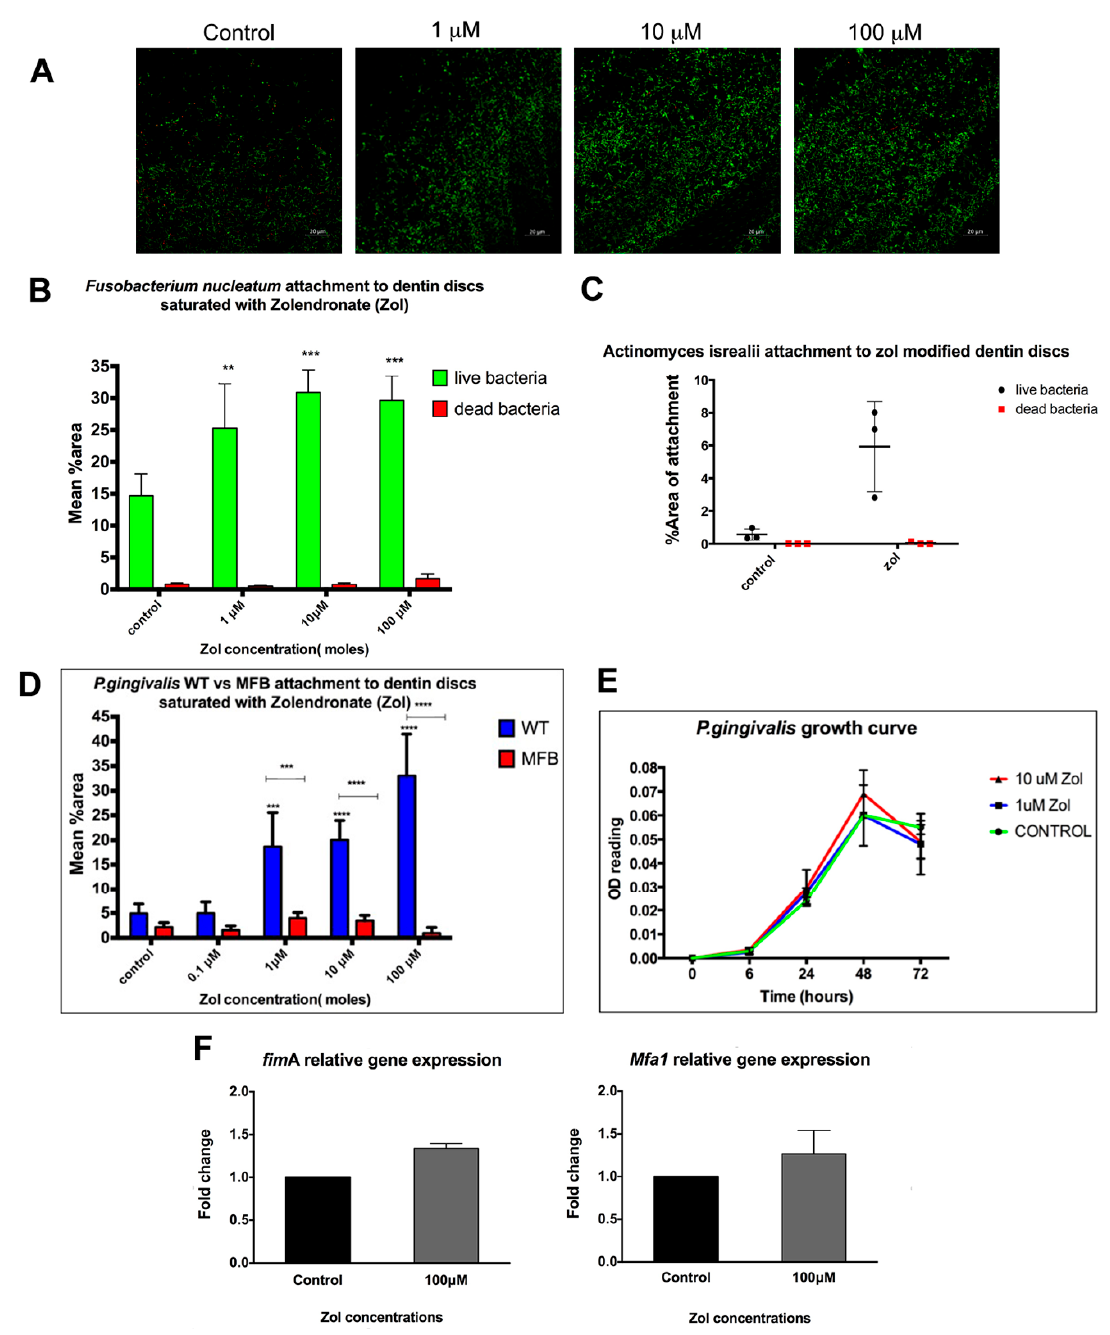
Figure 1. Effect of matrix-bound zol on the attachment of different bacterial strains. ( A ) Confocal microscopy images of F. nucleatum stained with a fluorescent live (green) and dead (red) stain on zol-coated dentin discs. ( B ) Summary bar graph of the quantitative analysis of F. nucleatum ’s attachment to zol-coated dentin discs. ( C ) Summary bar graph showing A. Israelii ’s attachment to zol-modified dentin discs. ( D ) Mean % area attachment of WT P. gingivalis vs. MFB ( FimA − /Mfa1 − ) attachment on zol-coated dentin discs. ( E ) Growth curve showing P. gingivalis proliferation with zol treatment. ( F ) An rtPCR analysis showing the relative mRNA expression of the major ( fimA ) and minor ( mfa1 ) fimbriae in P. gingivalis with and without zol treatment. (Data represent mean ± SD of three independent experiments ** p < 0.01, *** p < 0.001, **** p < 0.0001).